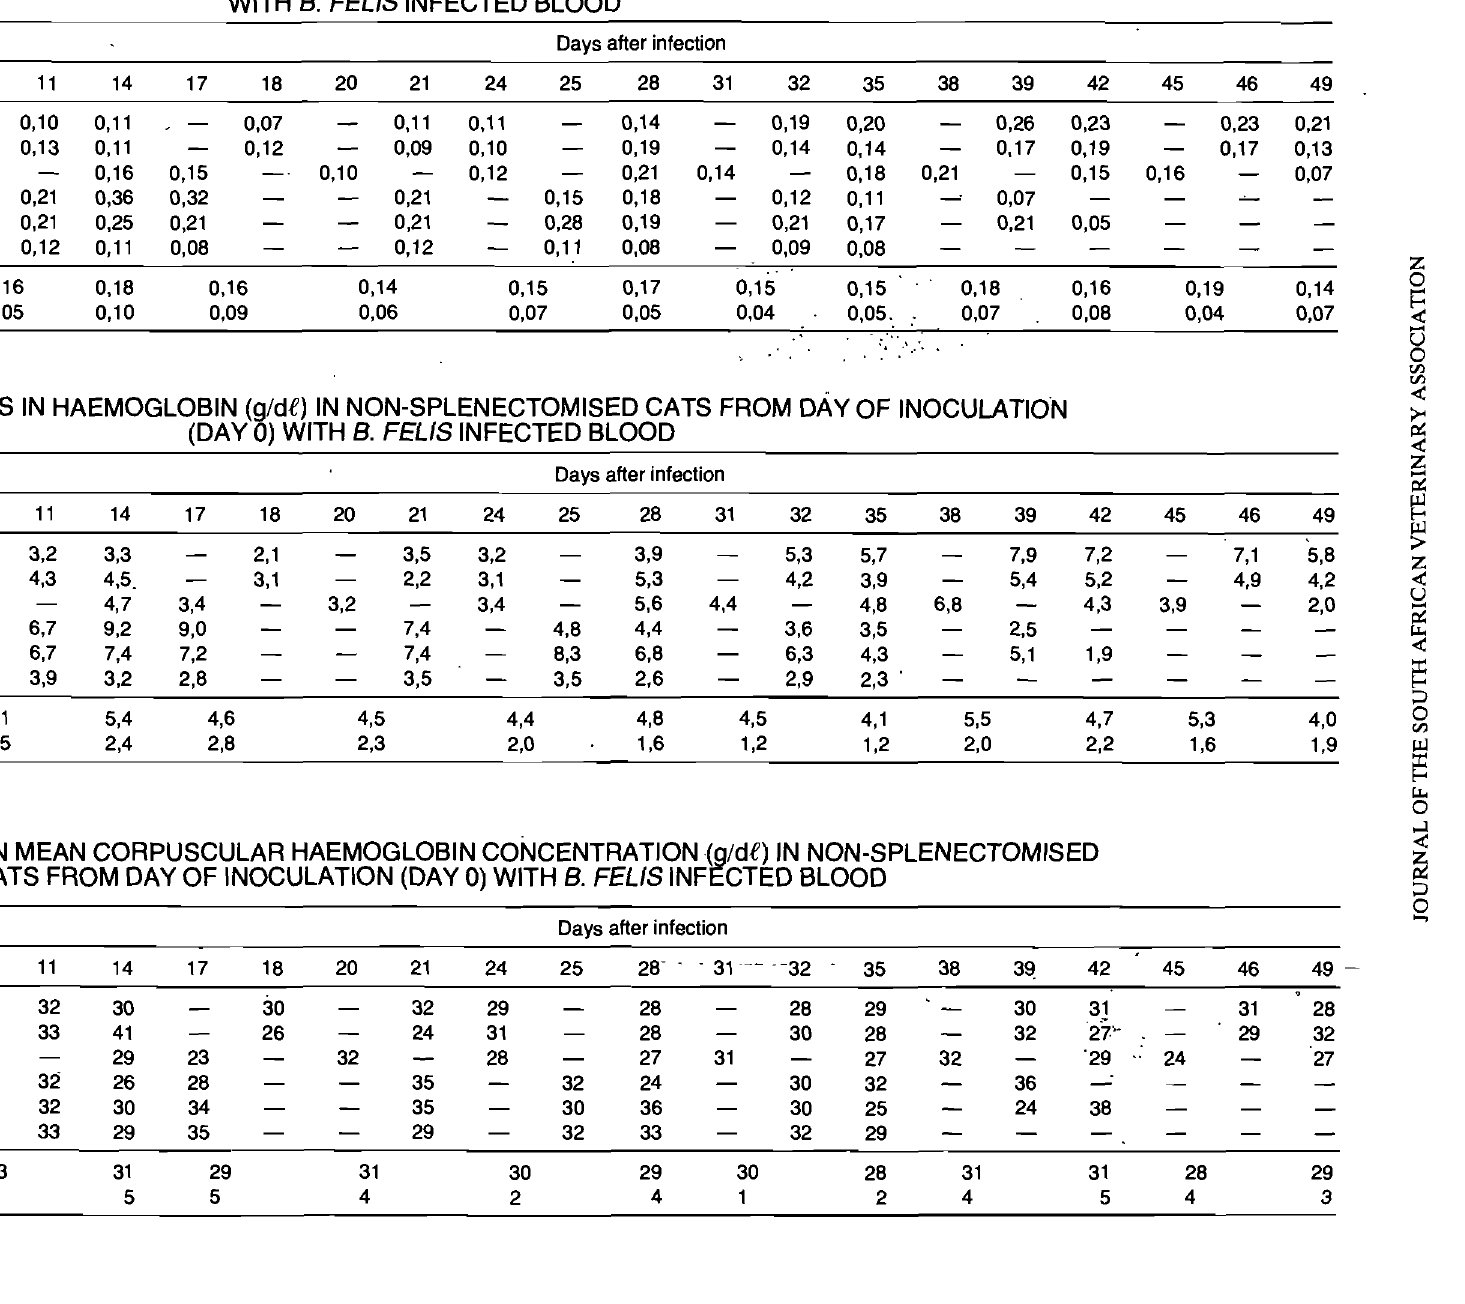
Table 3: CHANGES IN HAEMATOCRIT IN NON-SPLENECTOMISED CATS FROM DAY OF INOCULATION (DAY 0) r-- "'I WITH B. FELIS INFECTED BLOOD